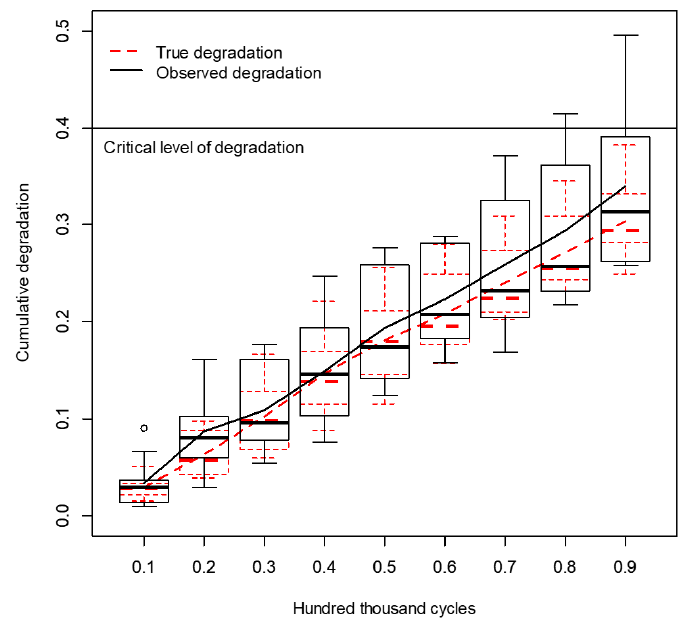
Figure 6. Illustration of differences between the observed degradation paths and true degradation paths.